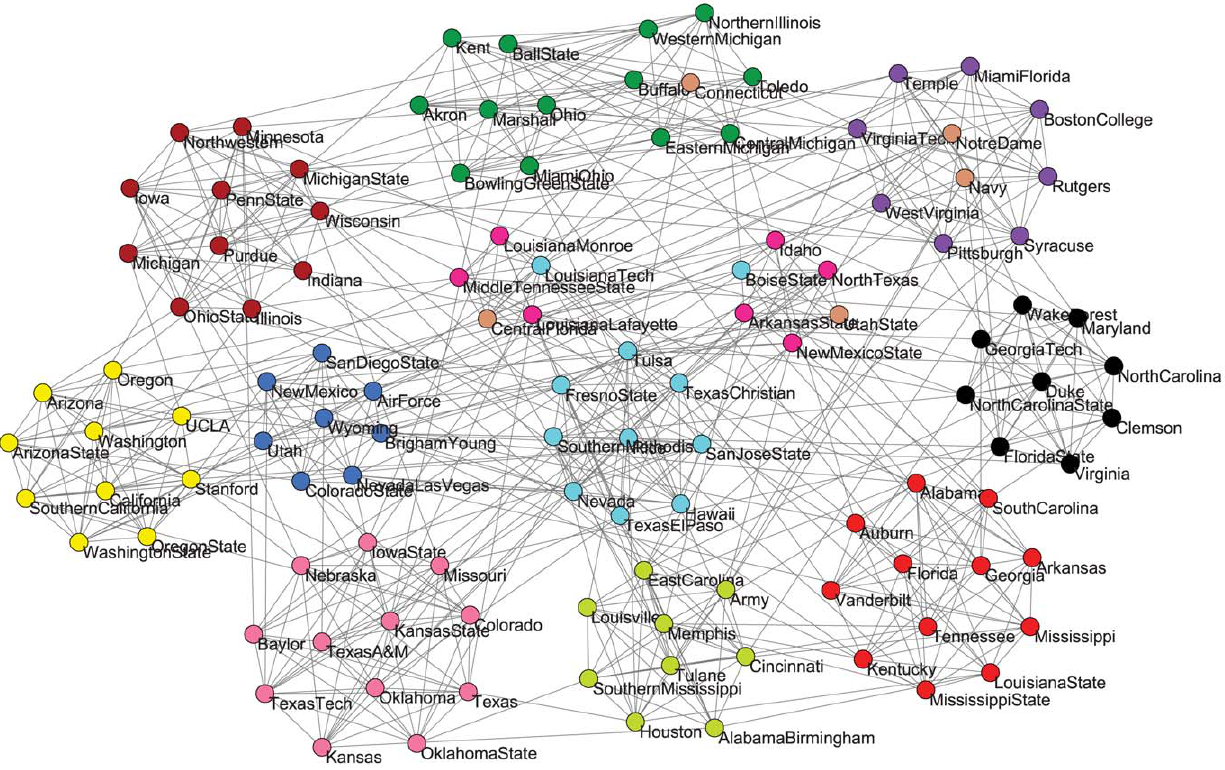
Figure 5. The NCAA college-football network and thirteen communities obtained by our algorithm on it with a [ ½ 0 : 79 , 1 : 10 (cid:2) . The conferences are represented by the vertex groups and the detected communities are distinguished by different colors.